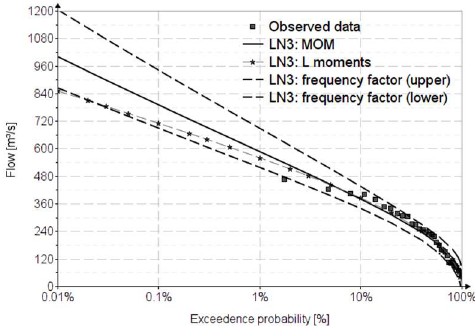
Figure 6. LogNormal distribution.